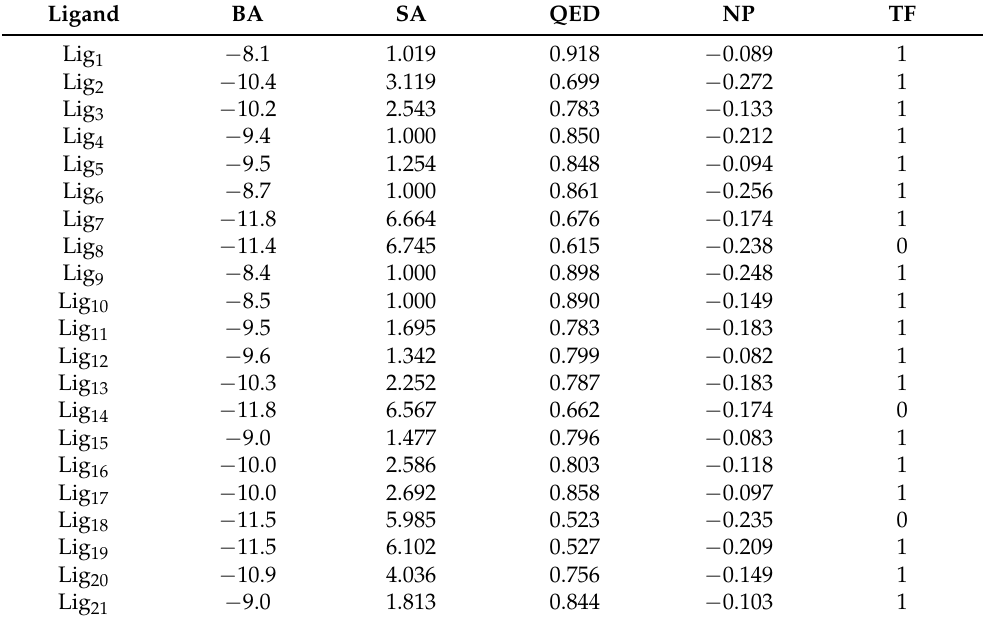
Table A2. The molecular metrics of the 21 ligands. These metrics are described in Section